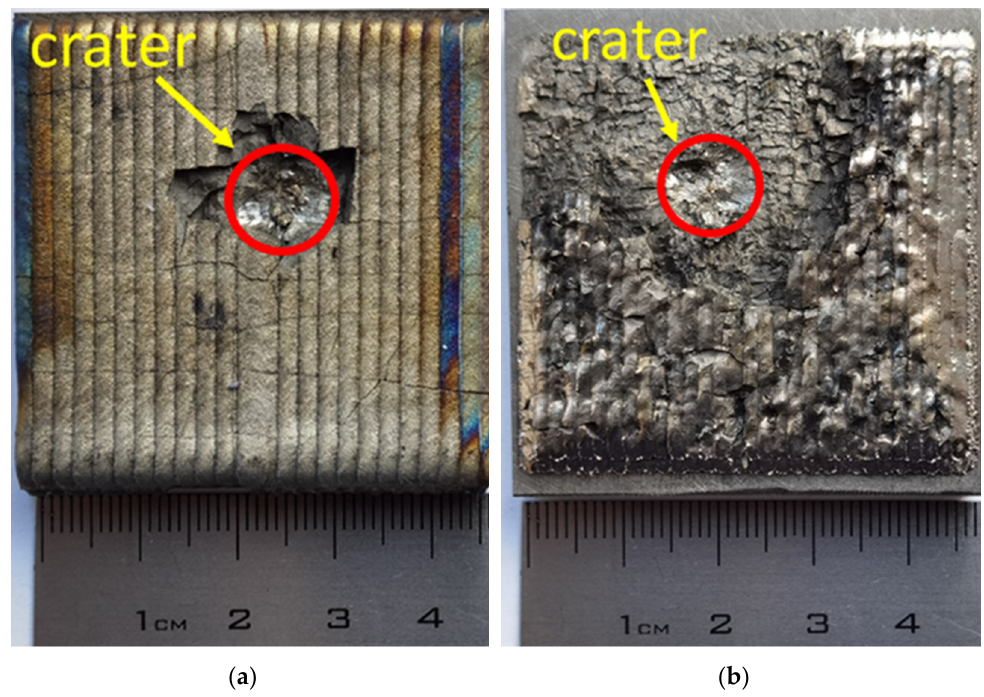
Figure 9. Photographs of the coating after impact testing: ( a )-Ti64 + SiC ceramic particles (DMD), ( b )-Ti64 + SiC ceramic fibers (LSC).